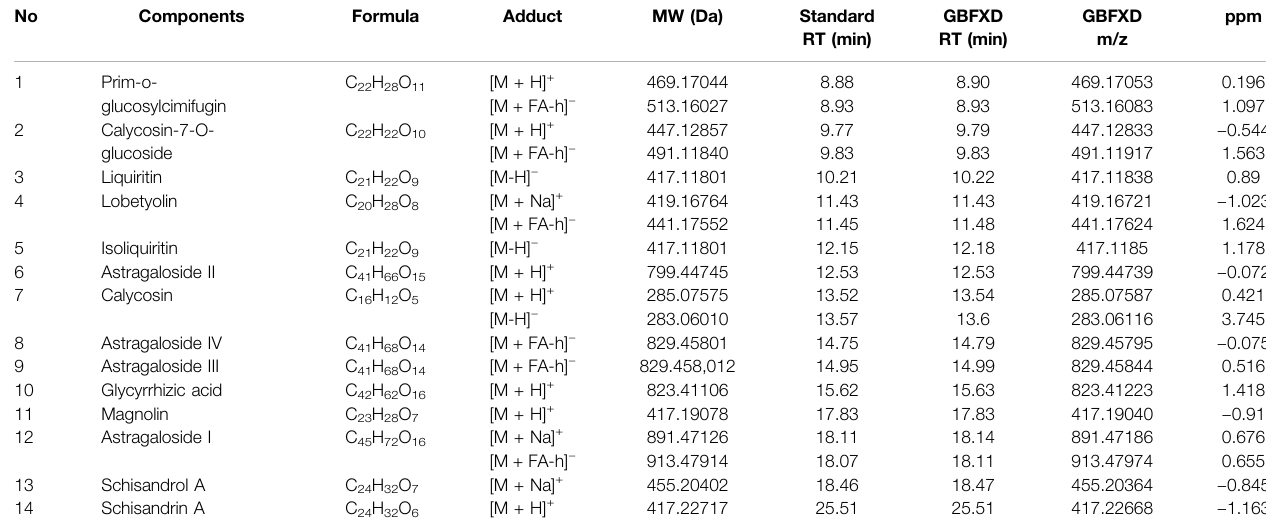
TABLE 2 | The chemical components identi fi ed from